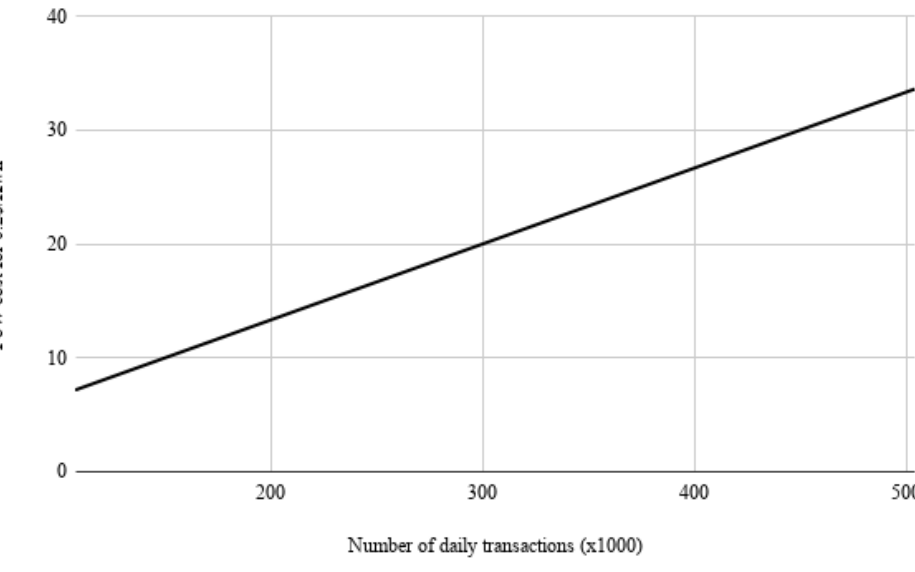
Figure 15. System scalability in terms of Proof of Work (PoW) cost. X-axis is the number of transactions in units of